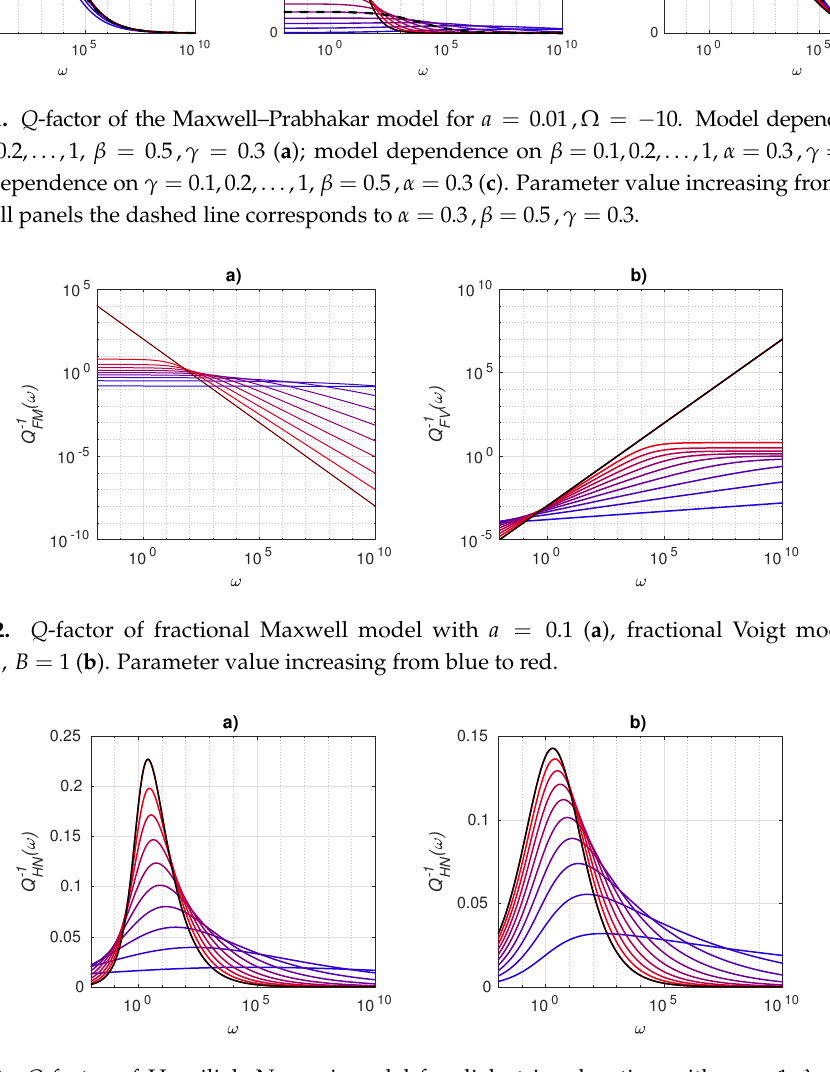
Figure 3. Q -factor of Havriliak–Negami model for dielectric relaxation with a = 1, λ = 1 and α = 0.1,0.2,. . .,1, γ = 0.5 ( a ), or a = 1, λ = 1 and γ = 0.1,0.2,. . .,1, α = 0.5 ( b ). Parameter value increasing from blue to red. Decreasing a , the widths of the curves become wider, while increasing λ , the peak results are shifted to larger ω for lower α